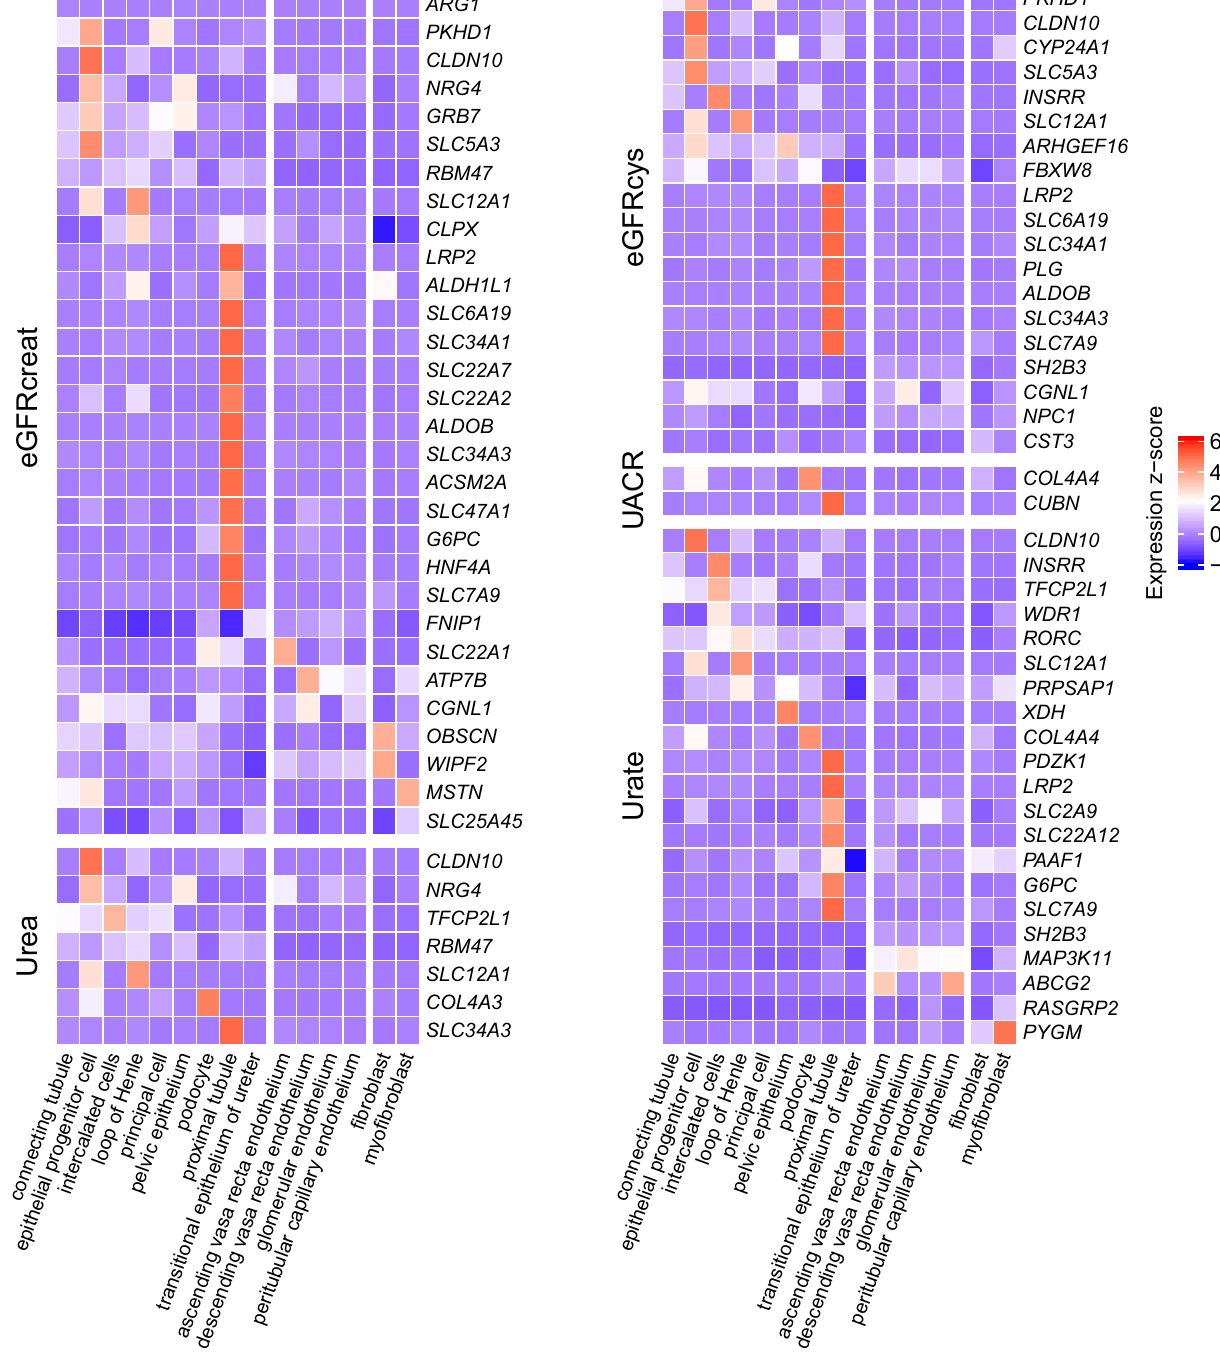
Fig. 5 | Expression of associated genes from gene-level analyses in kidney cell types. Heatmaps showing cell type-speci fi c expression of associated genes in eGFRcrea,eGFRcys,urea,UACR,andurate.Theexpression z -scorevaluesarebased on single-cell RNA-seq data from Stewart et al. 25 Fifteen non-immune kidney cell